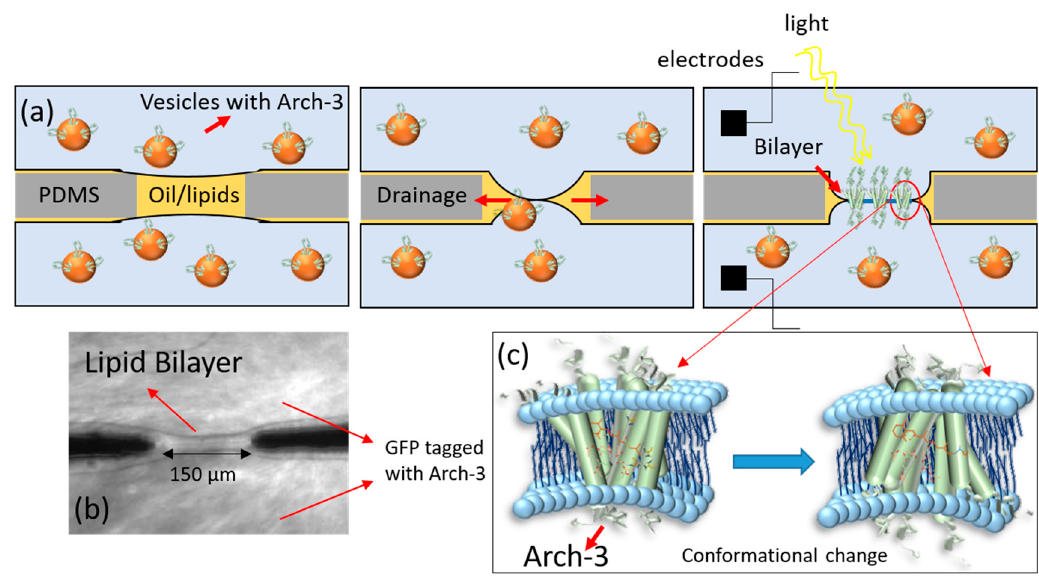
Figure 1. ( a ) A schematic of the formation of a lipid bilayer at the intersection of two microfluidic channels. First, the channel is filled with oil–lipid solution. Then, a cell-free expression reaction solution containing synthesized Arch-3-EGFP fused to the membrane of vesicles is injected into both channels. A remaining oil–filled lipid bilayer separates the two channels (left). Lipids from the oil phase and lipid vesicles with the inserted Arch-3-EGFP from the aqueous phase form a monolayer at both oil–water interfaces. As oil drains into the PDMS, the two interfaces gently meet to form a lipid bilayer containing Arch-3-EGFP (middle). The visualization of the inserted Arch-3-EGFP is achieved by exciting EGFP with blue light. AgCl electrodes inserted into the microfluidic device are used for electrical measurements (right). ( b ) The image shows the fluorescent signal of the EGFP tag from Arch-3 at the site of the suspended bilayer; PDMS elements remain dark. ( c ) The image shows the conformational changes of Arch-3 upon light exposure mediated by the deprotonation of retinal. This results in proton pumping which can be detected using electrophysiological measurements (scheme based on channel rhodopsin, adapted from [22]).